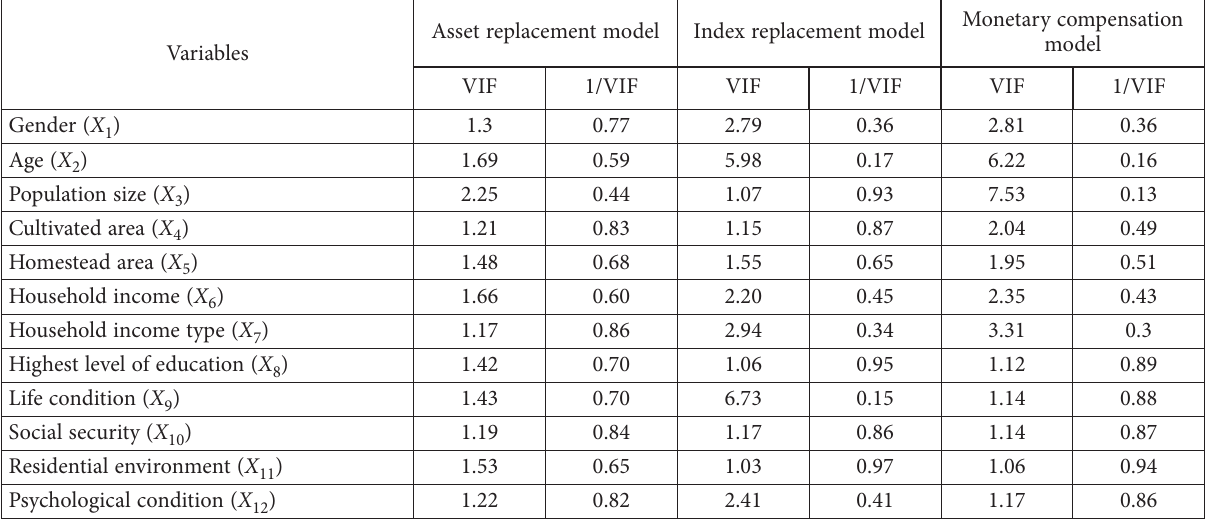
Table 2. Multicollinearity test results of HW pattern